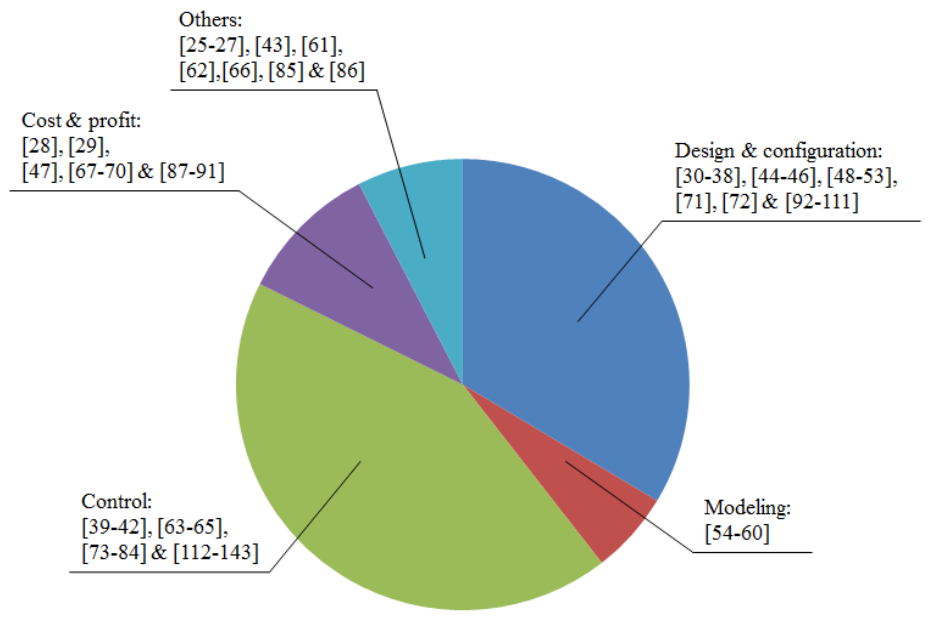
Figure 3. Categories of reviewed papers according to technical focuses.